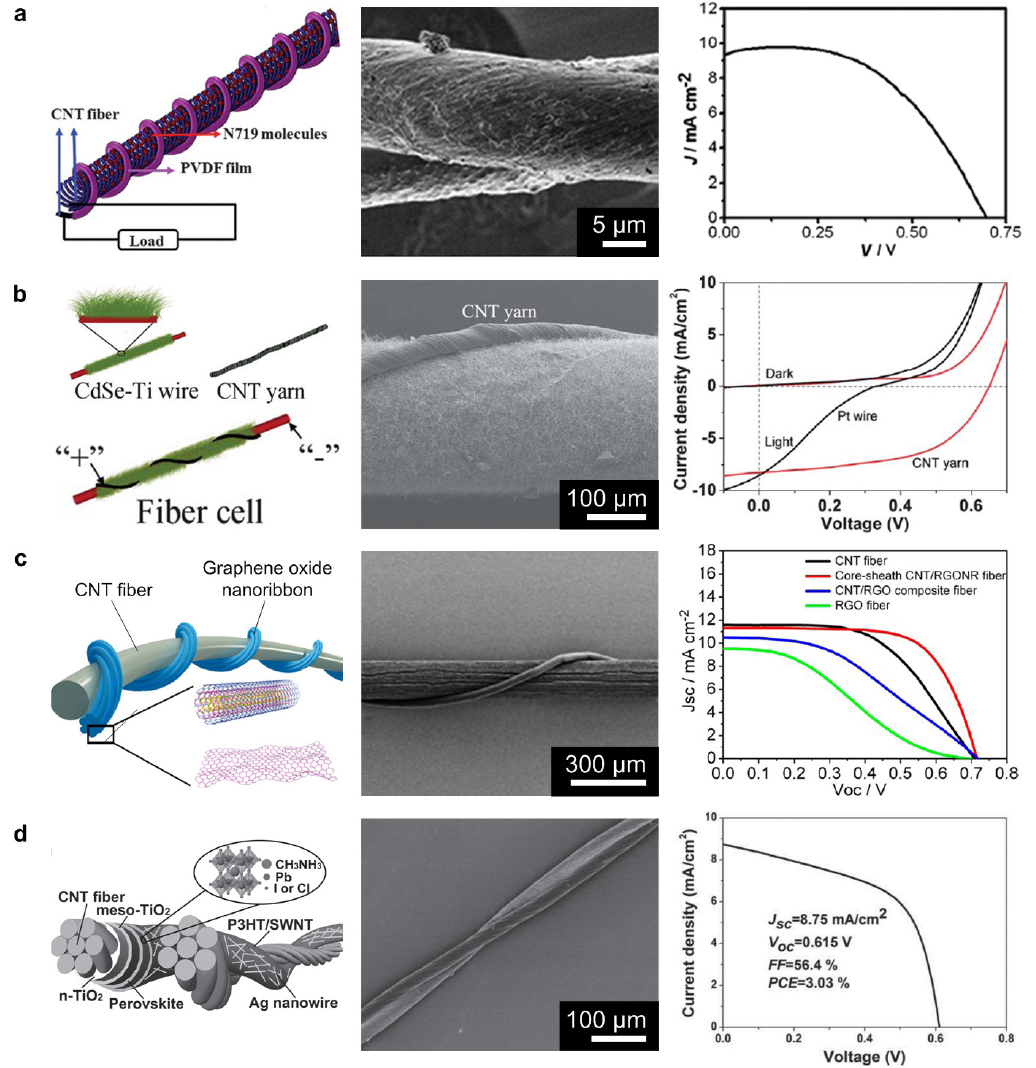
Figure 10. ( a ) Schematic ( left ) and SEM image ( middle ) of the twisted CNT/N719 working electrode and carbon nanotube/poly-vinylidene fluoride (CNT/PVDF) counter electrode. A typical density–voltage (J–V) curve ( right ) with improved performance after modification of the working electrode; ( b ) Schematic fabrication process ( left ) and SEM image ( middle ) of photo electrochemical cells with a primary electrode of Ti wire, light absorption layer of CdSe nanowire, and counter electrode of CNT. J–V curves under dark and light conditions of different fiber cells using a CNT yarn and Pt wire counter electrode; ( c ) Schematic ( left ) and SEM image ( middle ) of wire shaped dye-sensitized solar cells with twisted CNT fiber. Current density-voltage curves for a wire-shaped DSC ( right ); ( d ) Schematic diagram of double twisted solar cell supported by the CNT fiber and the chemical structure of the perovskite material ( left ). The SEM image shows twisted fibrous solar cells ( middle ). The current J–V curve is shown for electrical performance ( right